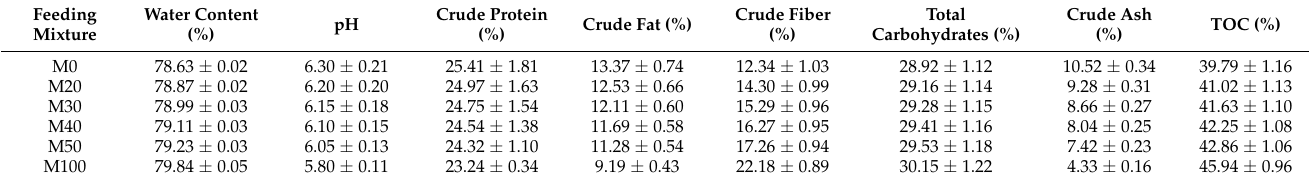
Table 3. Survival rate, prepupal rate, and larval production of BSFL fed on SCR and KW and their co-digestion mixtures. Dry mass reduction, bioconversion, and FCR of BSF converting the